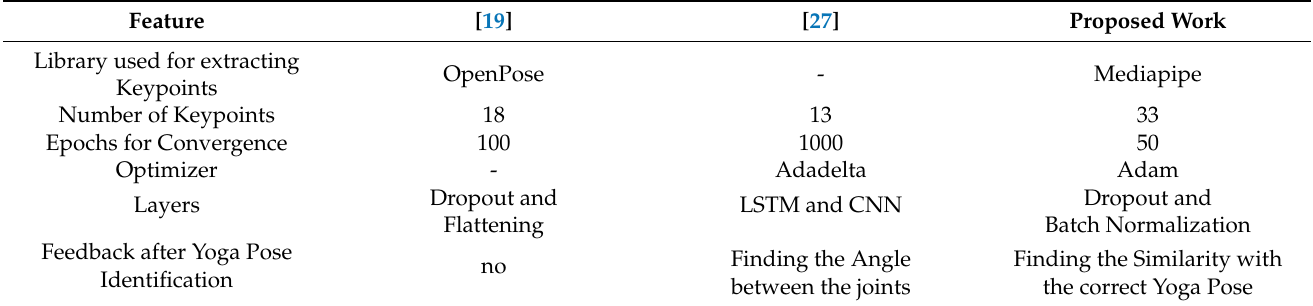
Table 2. Differences with other